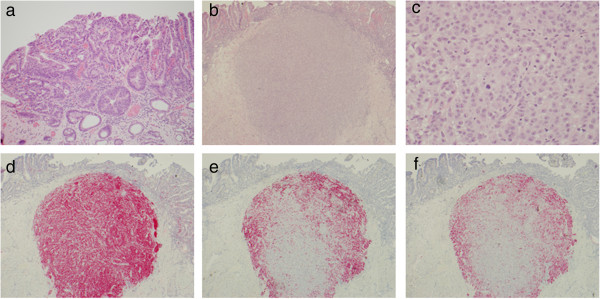
Histological and immunohistochemical findings. a) Barrett esophagus with high grade dysplasia present in the patient’s resection material (H&E, 100X). b) Second tumor nodule present within the mucosa and submucosa with distinct histologic features including c) large epithelioid cells with atypical nuclei with prominent nucleoli and frequent mitotic activity (H&E, 40X; H&E, 400X respectively). Immunohistochemical testing demonstrated the second tumor was positive for d) S-100, e) HMB-45 and f) Melan-A (each 40X).